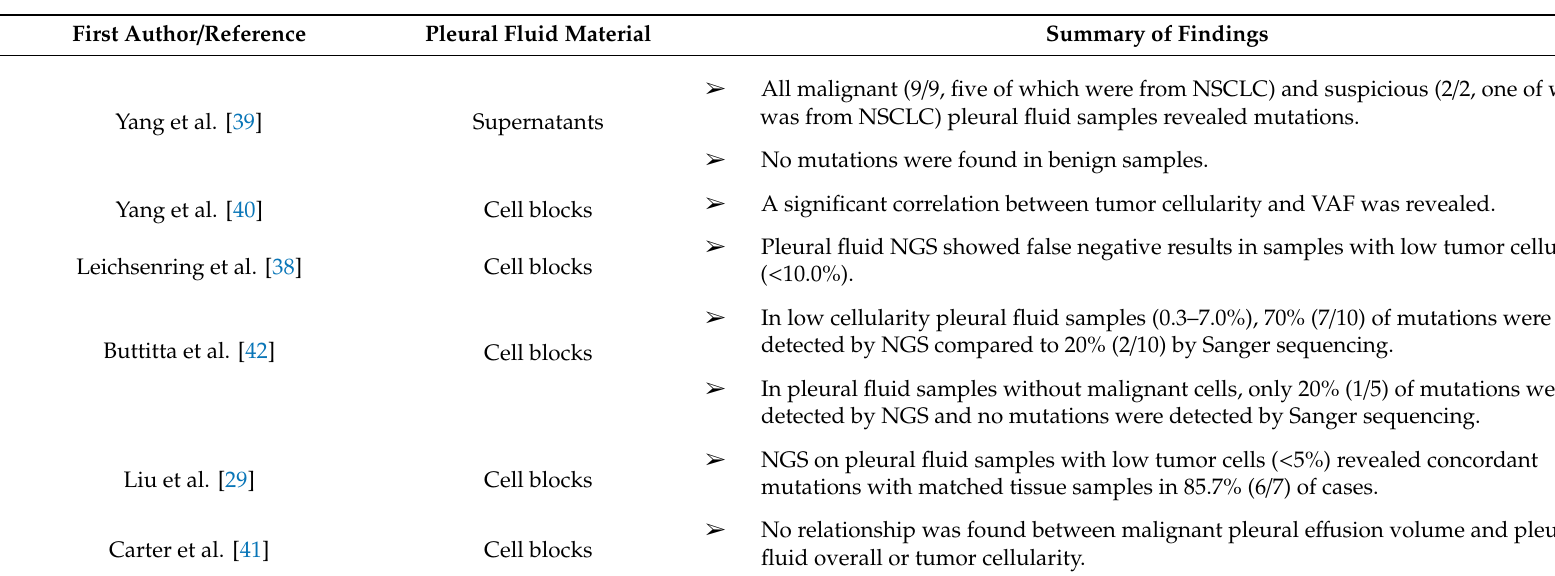
Table 2. Correlation of pleural fluid NGS with cytomorphologic findings and tumor